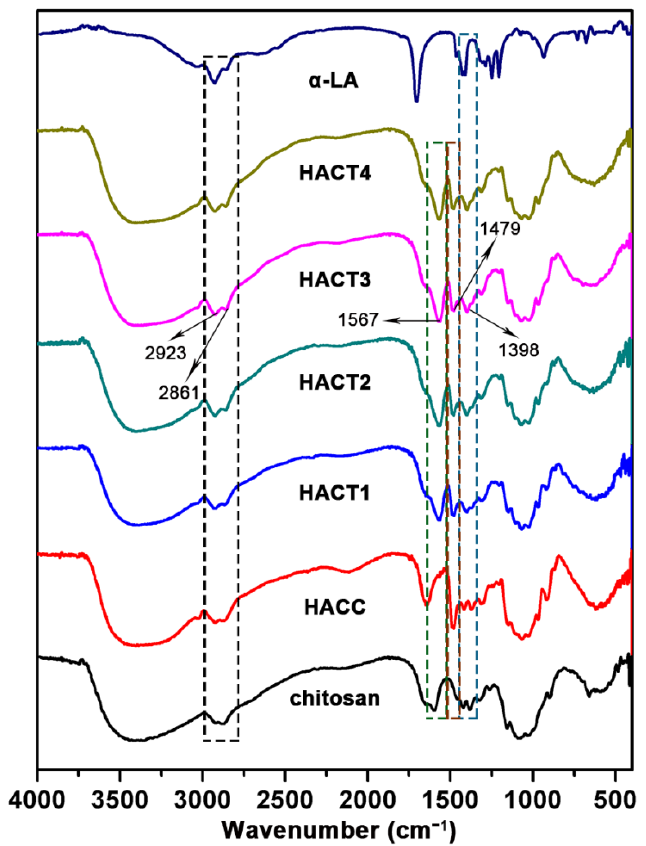
Figure 1. FTIR spectra of chitosan and chitosan